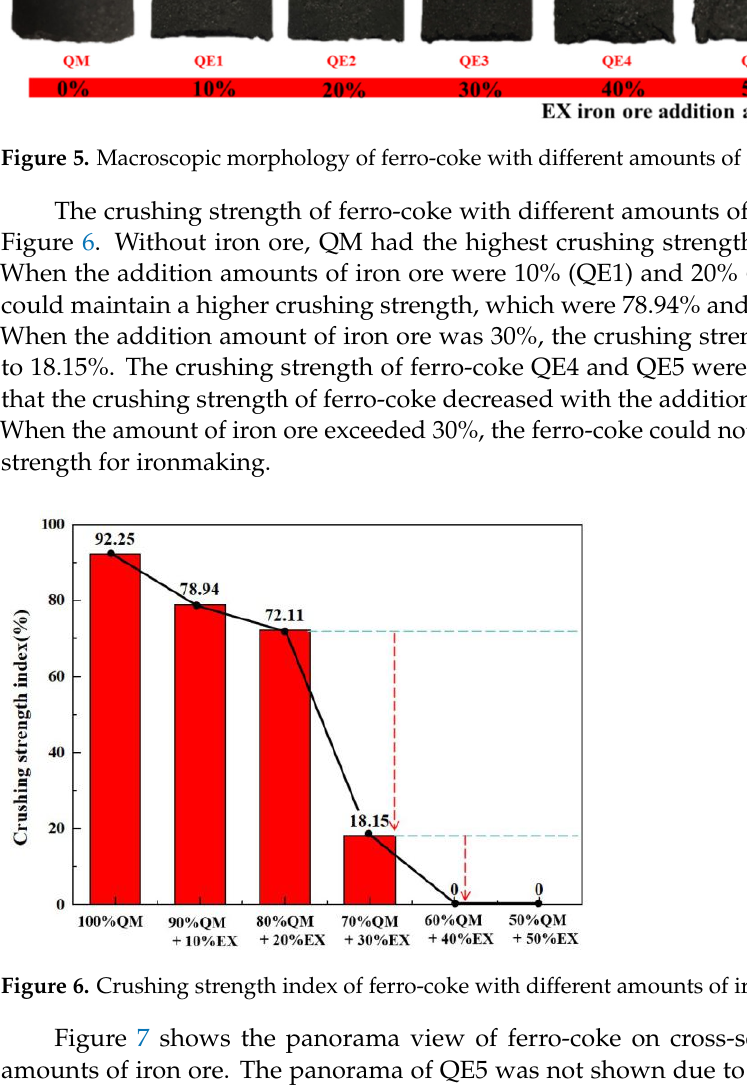
Figure 6. Crushing strength index of ferro-coke with different amounts of iron ore.